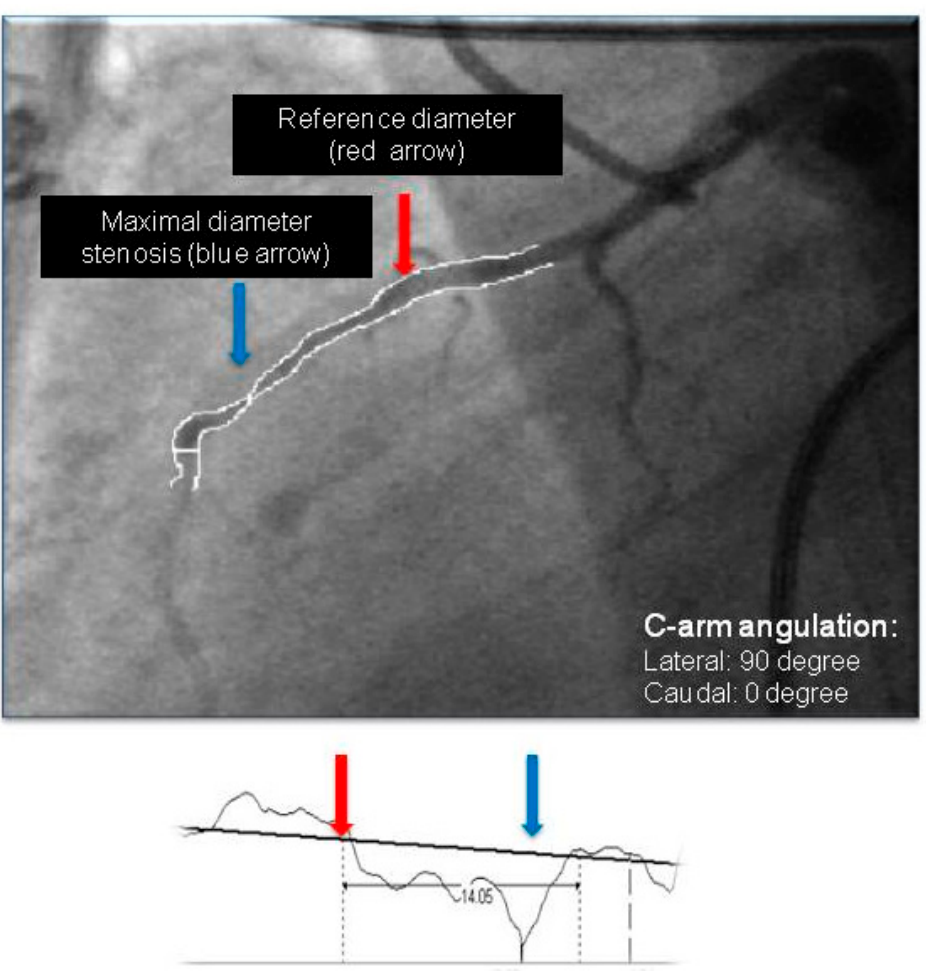
Figure 2. Representative image of a measurement process in lateral view (end-systole) by quantitative coronary angiography (QCA).